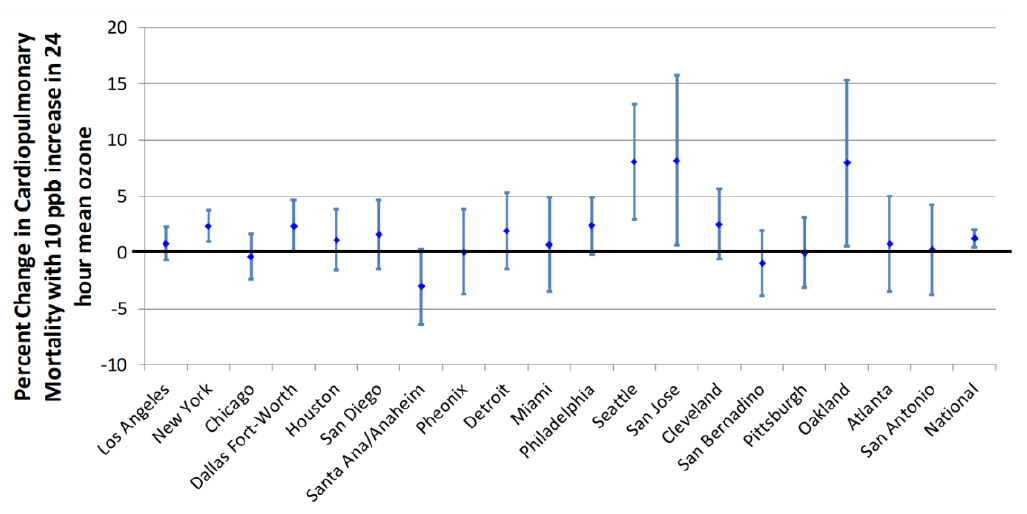
Figure 2. Regional heterogeneity in cardiopulmonary mortality estimates from Huang et al. (2005) [45]. Estimates whose error bars cross the x-axis at zero (thick black line) are not statistically significant. The highest mean daily ozone levels in these cities for this analysis were in San Bernadino, San Diego, Los Angeles, Phoenix, and Dallas-Fort Worth. The lowest mean ozone levels were in Oakland, Miami, San Jose, Houston, and Seattle.